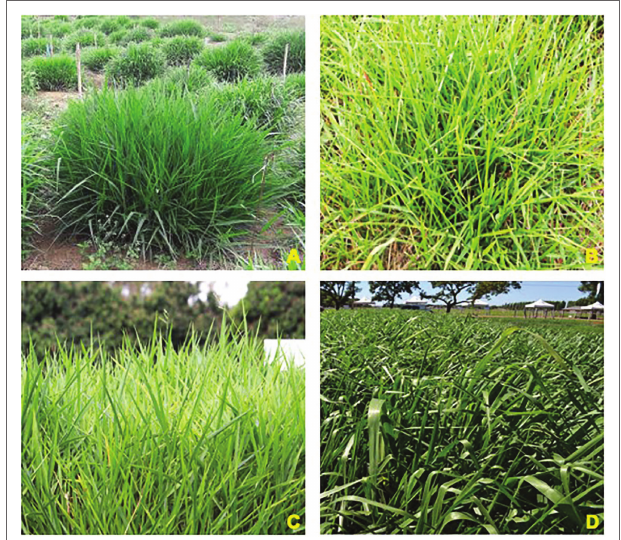
FIGURE 1 | Main Urochloa species most commonly used in tropical pastures. (A) Urochloa ruziziensis , (B) U. humidicola cv. Tupi, (C) U. decumbens cv. Basilisk, and (D) U. brizantha cv. Piatã. Source of the photographs: